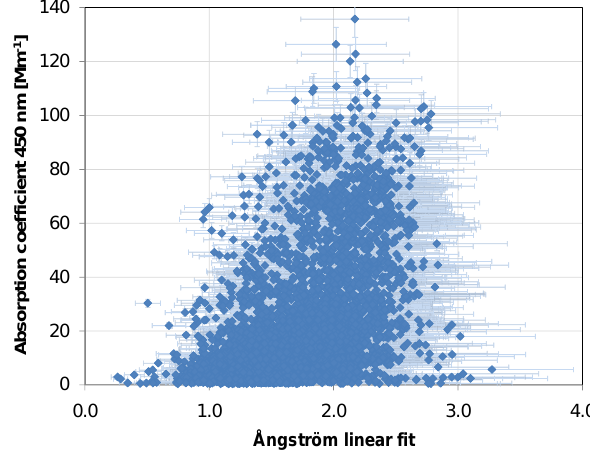
Fig. 6. Aerosol absorption coefficients at 450nm versus ˚Angstr¨om exponents calculated by a linear fit over the observed spectral range (450–950nm) for the SMOCC experiment data (Pasture Dry to Wet 2002). Error bars represent typical uncertainties: ± 5% in σ abs and ± 20% in ˚a abs